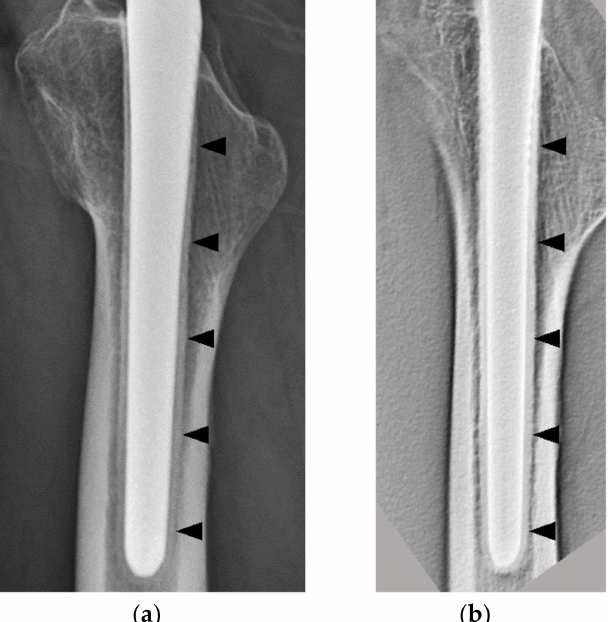
Figure 4. An 81-year-old female patient 3 y after THA. ( a ) Plain radiographs (lateral view); there was bone formation surrounding the stem (black arrowheads). ( b ) DTS (lateral view); in the same patient as in ( a ), bone formation was observed uniformly around the stem from proximal to distal (black arrowheads), and the stem–bone interface is seen more clearly in ( b ) than in ( a ). THA, total hip arthroplasty; DTS, digital